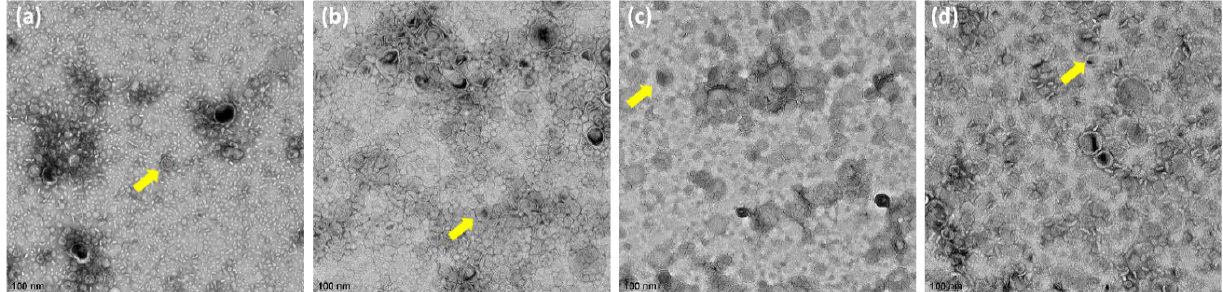
Figure 2. Morphology and size of OMVs from WT and mutant E. coli . ( a – d ) Transmission electron microscopy observation of E. coli BW25113, rfaC knockout (ΔrfaC), rfaG knockout (ΔrfaG), and rfaL knockout (ΔrfaL) strains, respectively. The yellow arrows show the example of observed OMV.